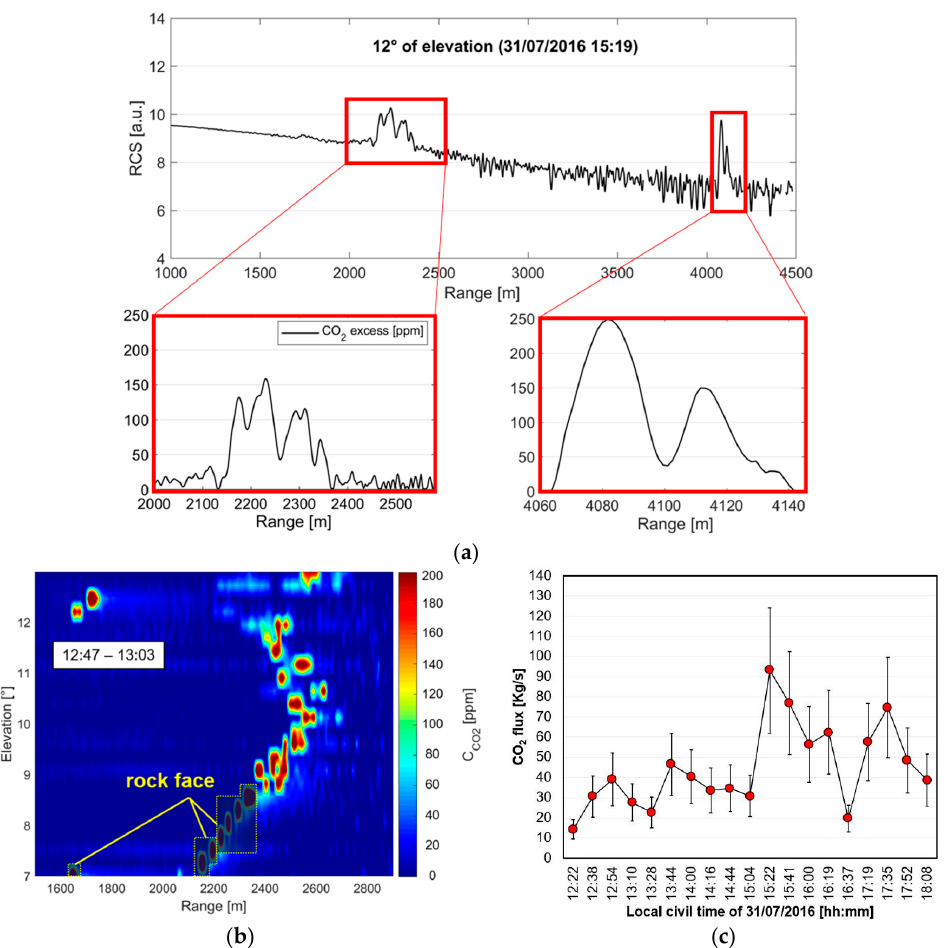
Figure 5. ( a ) Lidar return at 12° of elevation: two wide and jagged peaks from the volcanic plume are clearly visible; the CO 2 profiles inside the volcanic plume are shown in the two red boxes. The uncertainty was equal, respectively, to 6% for the left-side plume peak and 7.5% for the right-side plume peak. ( b ) Vertical scan (fixed azimuth: 230°) of the volcanic plume (CO 2 excess) acquired on